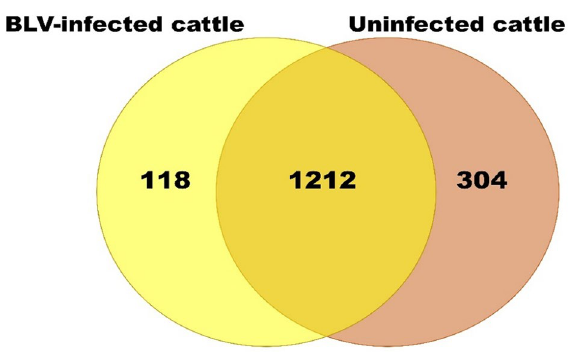
Figure 2. Comparative Venn diagram of milk sEV proteins between BLV-infected and uninfected cattle were